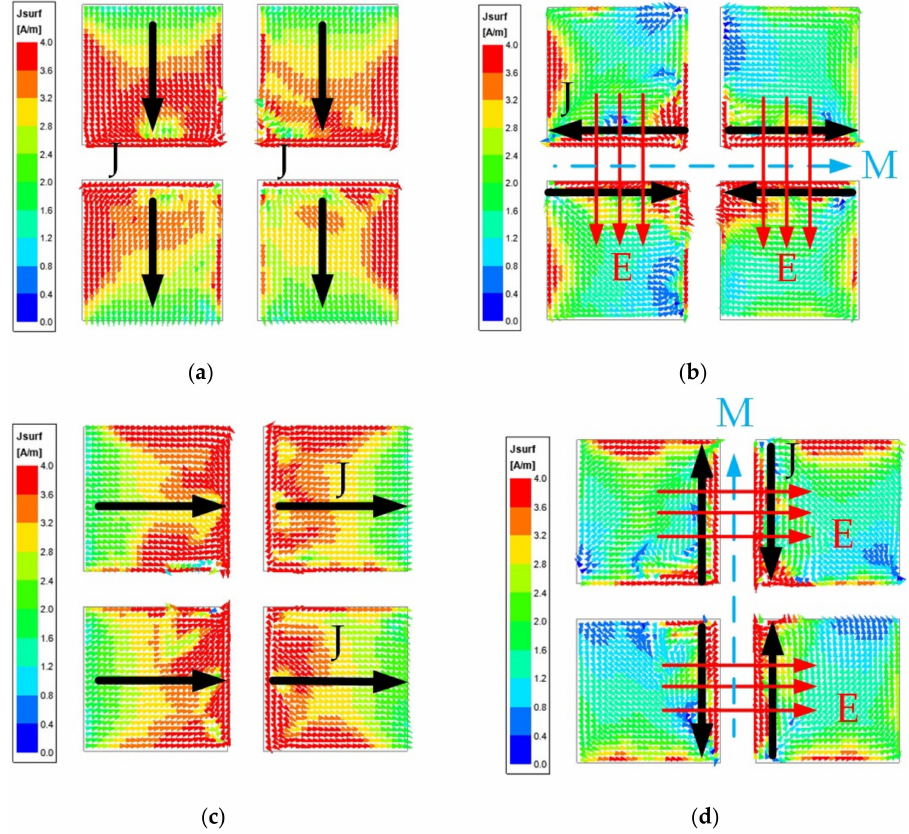
Figure 2. Simulated current distributions on the electric dipoles: ( a ) port1 at time = 0; ( b ) port1 at time = T/4; ( c ) port2 at time = 0; ( d ) port2 at time =